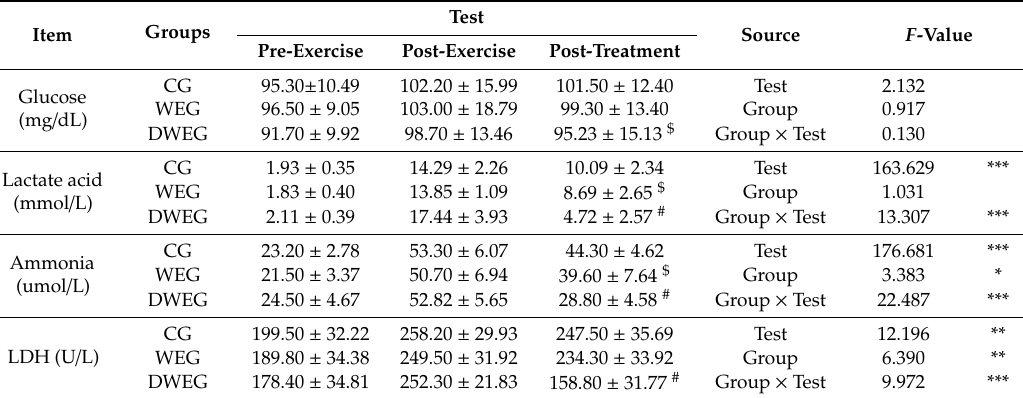
Table 4. Changes in fatigue recovery